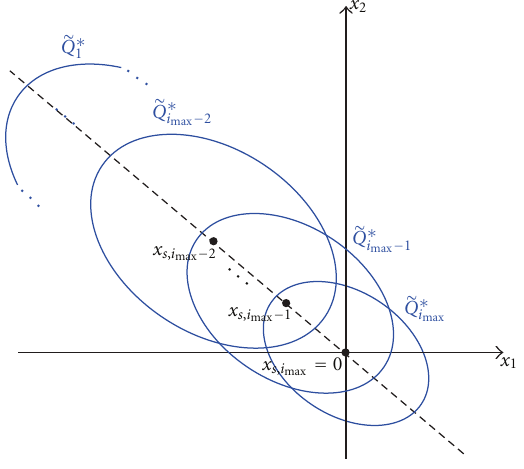
Figure 3: Result of the PR